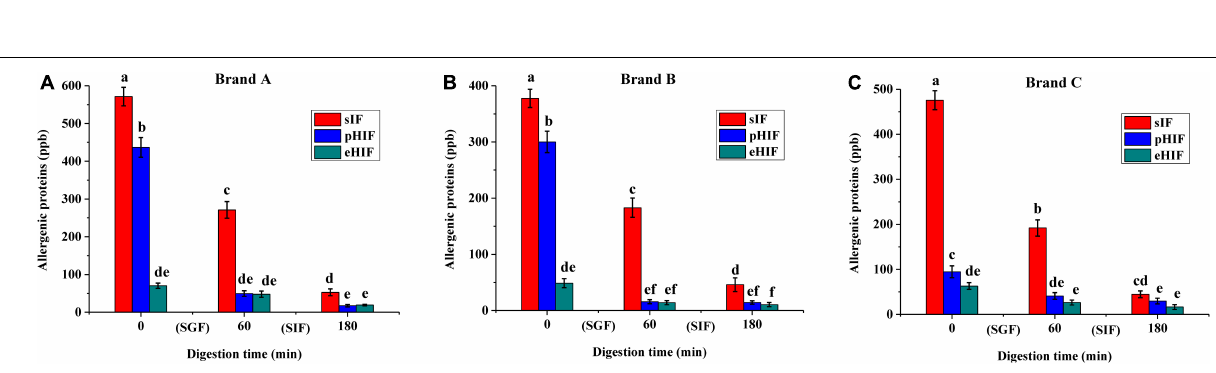
Frontiers in Nutrition |